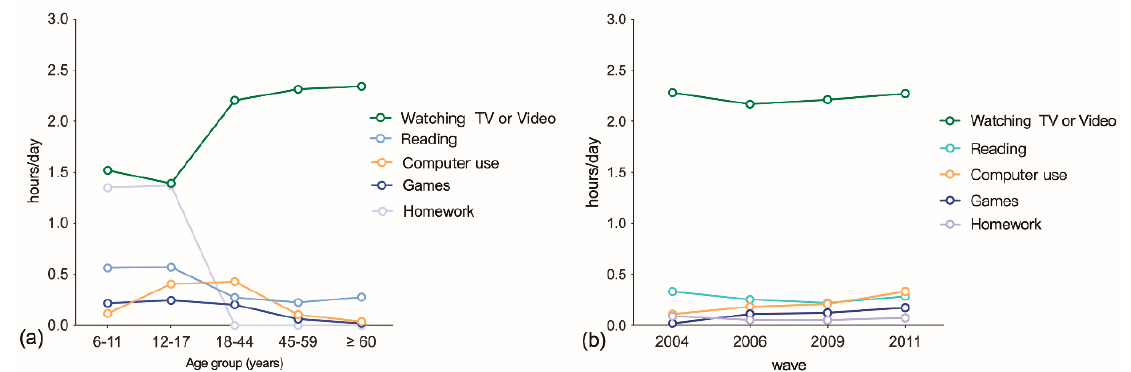
Figure 2. ( a ) Trends in leisure - time sedentary behaviors by age group among the Chinese popula- tion, CHNS 2004-2011; ( b ) trends in leisure - time sedentary behaviors by survey years among the Chinese population.